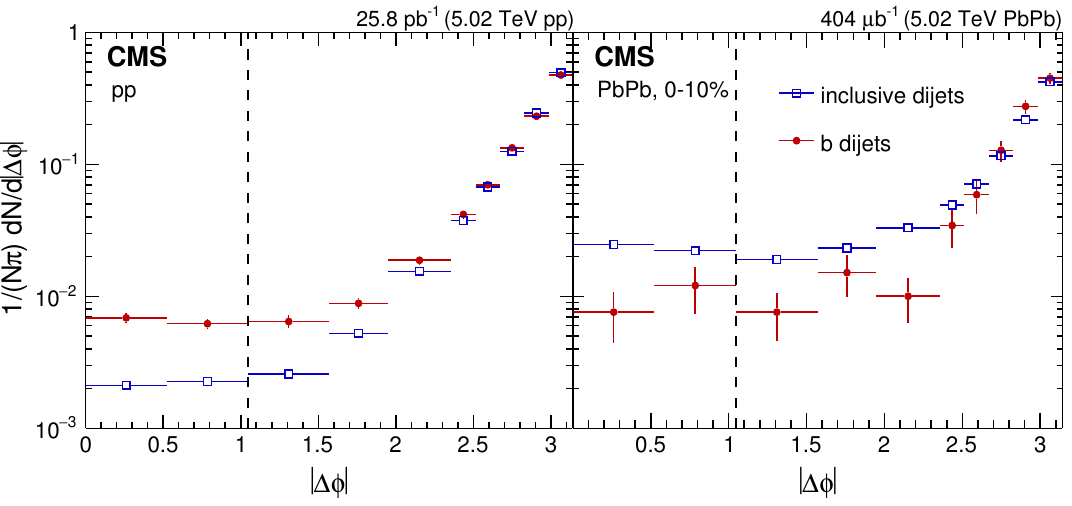
Figure 2 . Distributions of the azimuthal opening angle ((cid:1) (cid:30) ) between the leading and subleading jets for pp (left) and central (0{10%) PbPb collisions (right) for inclusive dijets and b dijets. The small-angle region ( j (cid:1) (cid:30) j < (cid:25)= 3), the boundary of which is indicated by a dashed line, is used to evaluate the combinatorial contribution in PbPb collisions. The vertical bars represent statistical uncertainties, while the horizontal bars represent the bin